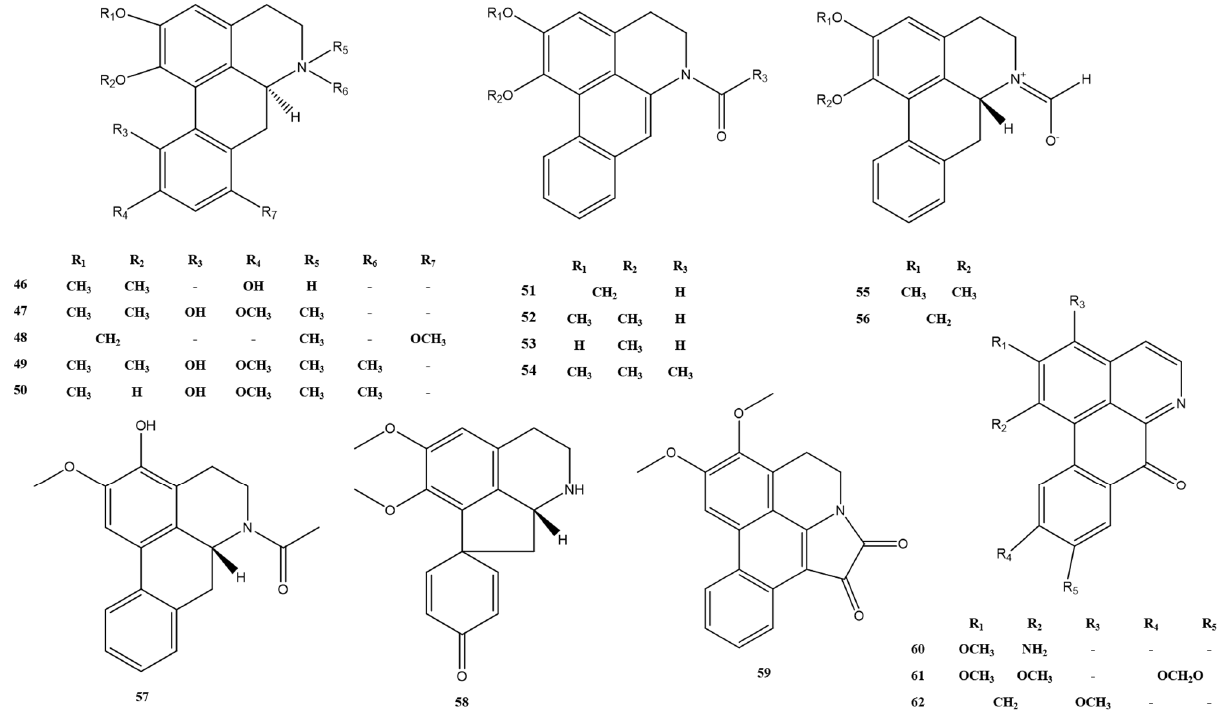
Figure 5. Apomorphine alkaloids in M. Rhizoma .